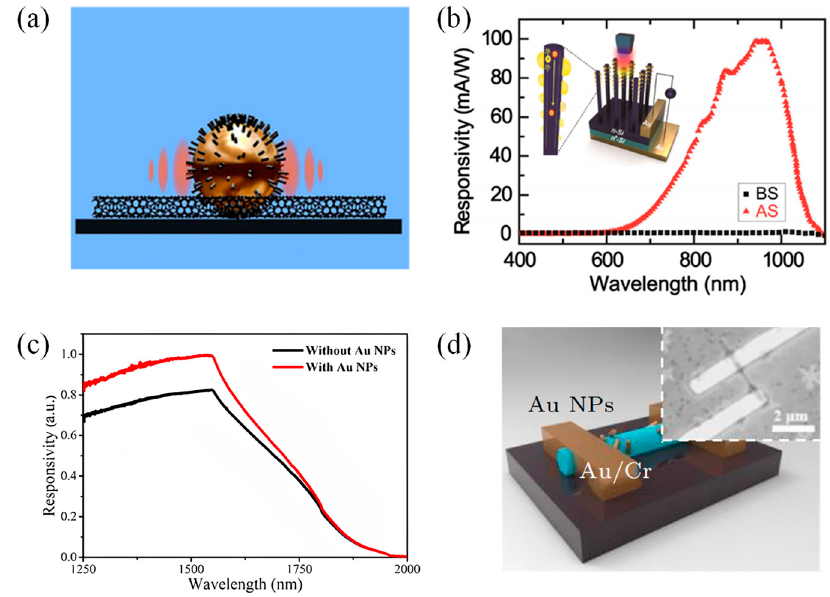
Figure 9. Structures and performance characterization of 1D materials-based infrared PDs with nanoparticles. ( a ) Plasmon coupling between Au nanoparticle and CNT when the polarization of the incident light is parallel to the CNT axis [74]. Copyright 2013, Applied Physics Letters . ( b ) Responsivity spectra for bare SiNW (black) and Au NP-coated SiNW (red) PDs. (Inset is a schematic illustration of the proposed PD consisting of Au hNP-coated SiNWs.) [75]. Copyright 2022, Nano Convergence. ( c ) Spectral response of the SWCNT/Ge PD with and without AuNPs [76]. Copyright 2013, Photonics ( d ) Schematic of a single GaAs NW PD; the inset is the SEM image [77]. Copyright 2022, Chinese Physics B .